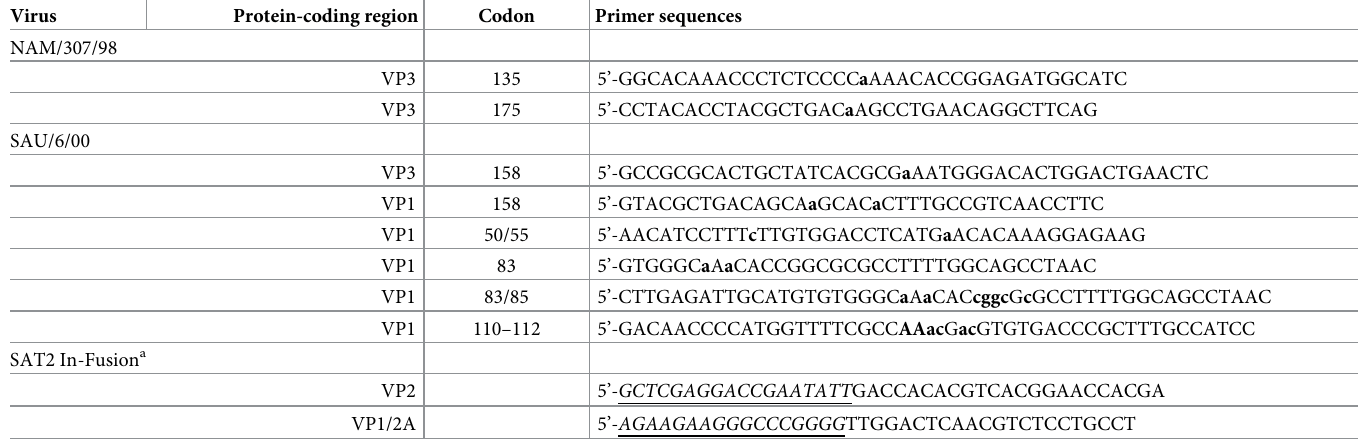
Table 4. Mutagenesis and In-Fusion cloning primer sequences. Virus Protein-coding